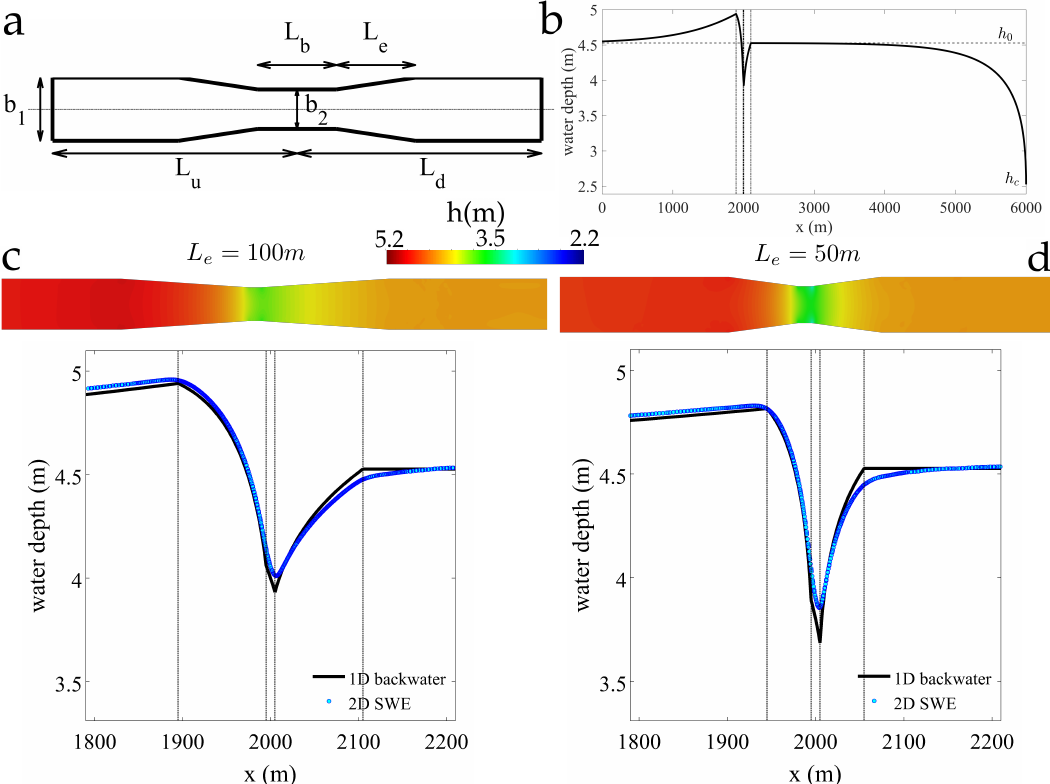
Figure 3. Comparison between 2D shallow-water simulations and 1D backwater curves for subcritical flow past a symmetric contraction in a long channel. ( a ) Schematic plot of the channel geometry, and full-channel water surface profile computed using the 1D theory. ( b ) Sample water surface profile along the center of the channel, for L u = 2000 m and L d = 4000 m, and L e = 100 m. ( c ) Comparison of water surface profiles predicted by the 1D and 2D models around the contraction, when the length of the expansion zone is L e = 100 m. ( d ) Comparison for L e = 50 m. The 1D prediction is more conservative: it yields a lower water depth at the narrowest section, therefore suggesting an earlier onset of critical flow conditions at the